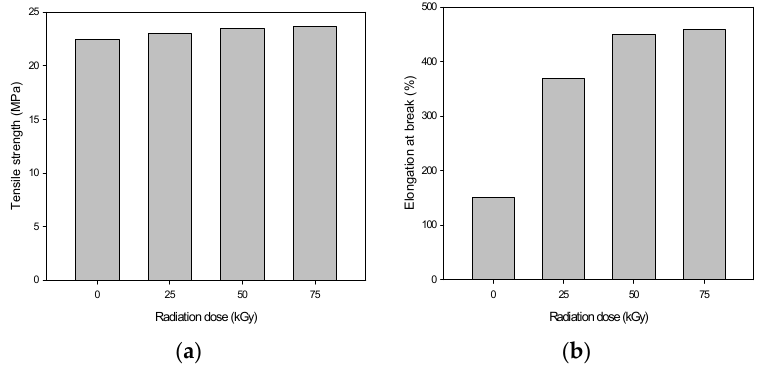
Figure 2. ( a ) Tensile strength and ( b ) elongation at break of PU (3 phr)/HDPE composite at various absorption doses.